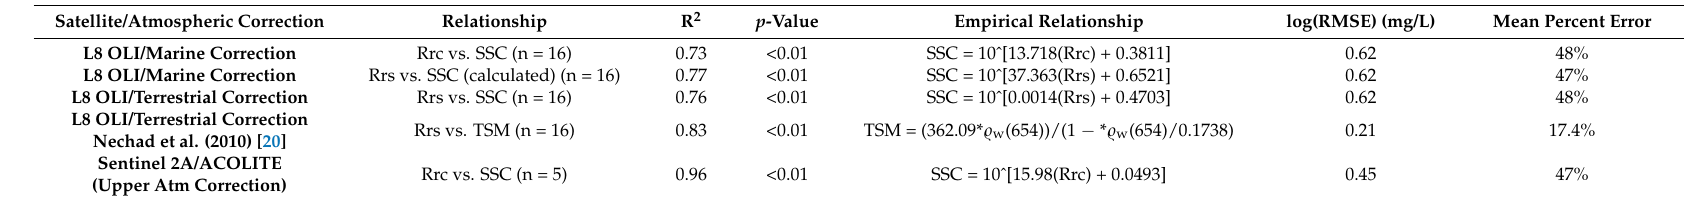
Table 2. Statistical relationships between satellite reflectance and USGS-sampled SSC.